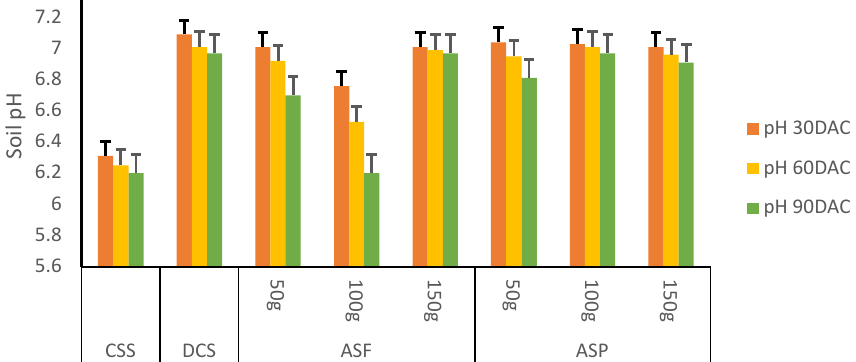
Figure 1. Change in soil pH levels in diesel contaminated soil during bioremediation analysis Values are means with standard errors. CSS = Control Soil, DCS = Diesel Contaminated Soil, ASF = Amended Soil with Fresh E. crassipes , ASP = Amended Soil with Powdered E. crassipes , DAC= Days After